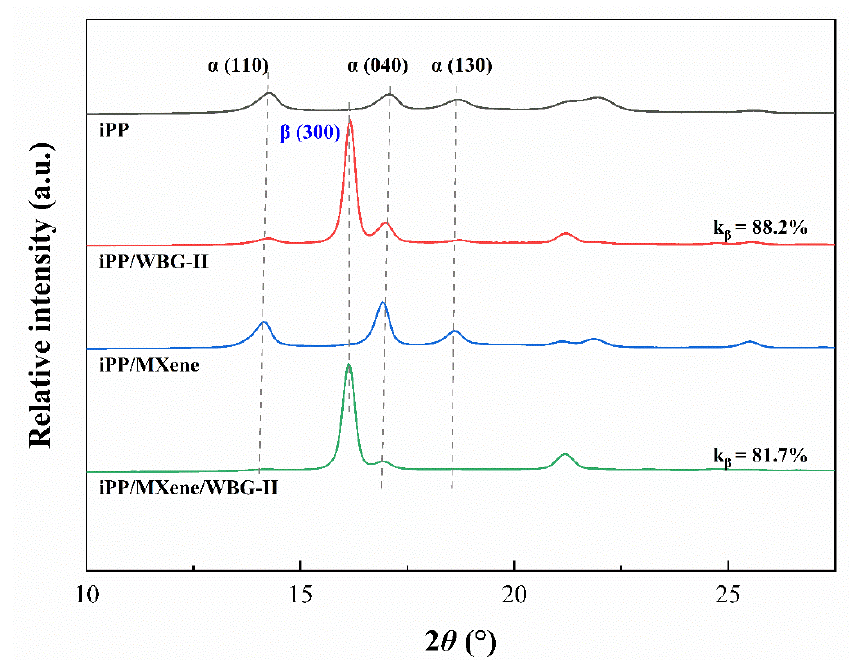
Figure 9. WAXD patterns of four samples.